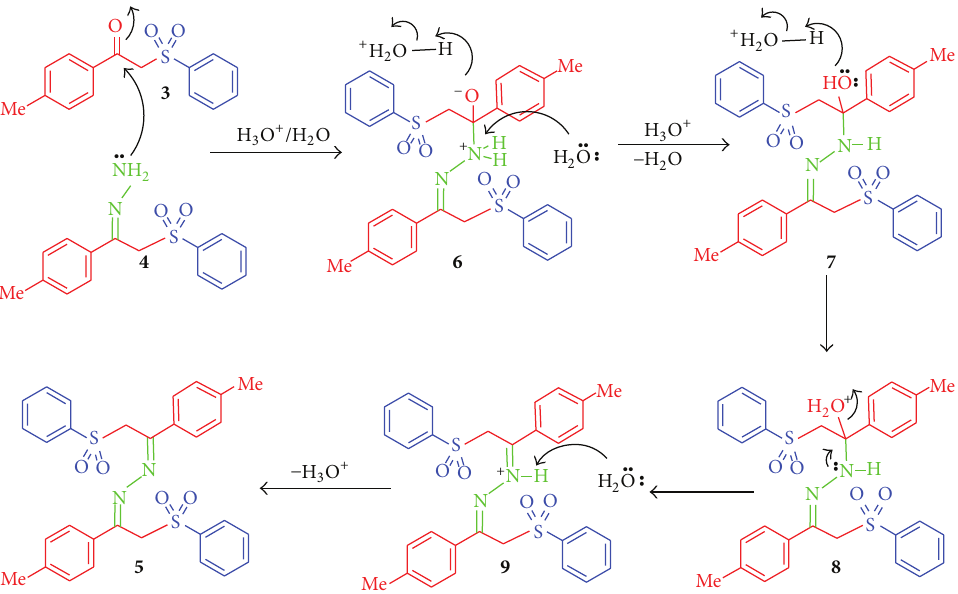
Figure 1: Mechanistic pathway of the reaction of intermediate 4 with compound 3 .